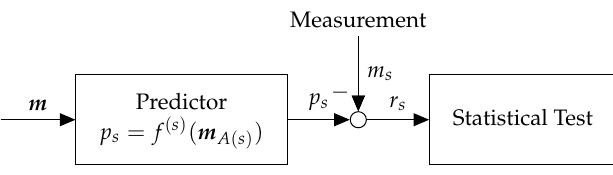
Figure 2. Regression-Based Anomaly